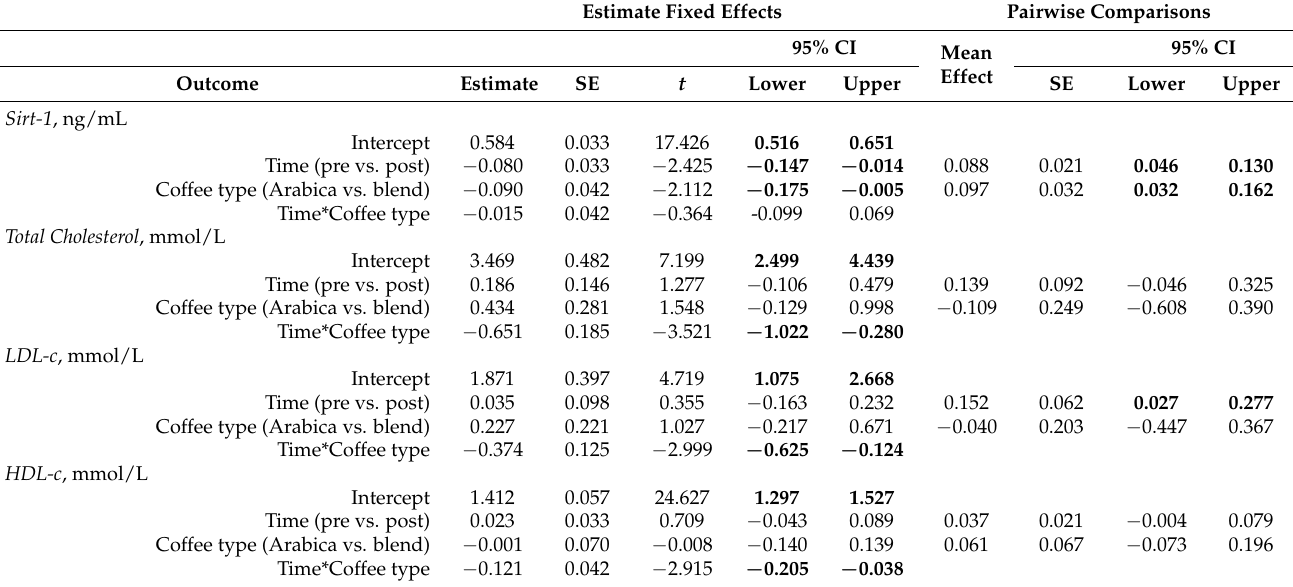
Table 4. Effects of different coffee powders on Sirt-1 and cholesterol adjusted by age and